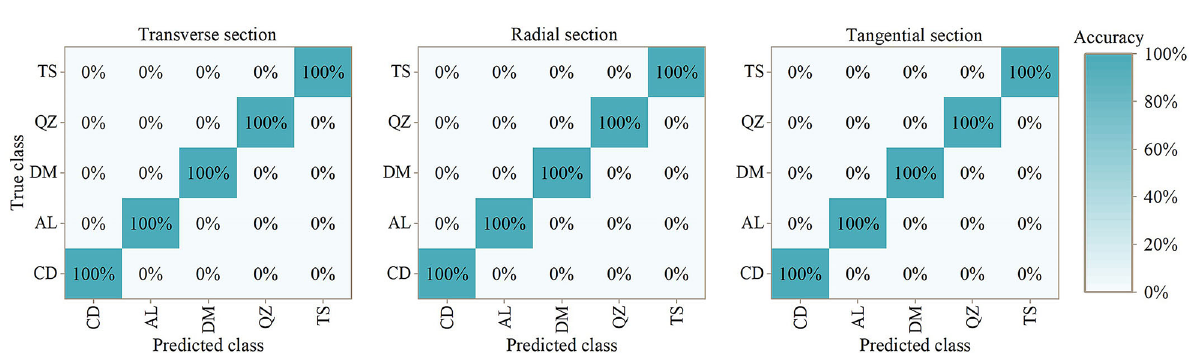
Figure 8. Mixing matrix for results of five Guiboutia species with SVM model (based on SPA spectral treatment). CD = G. conjugate ; AL = G. ehie ; DM = G. demeusei ; QZ = G. coleosperma ; TS = G. tessmannii